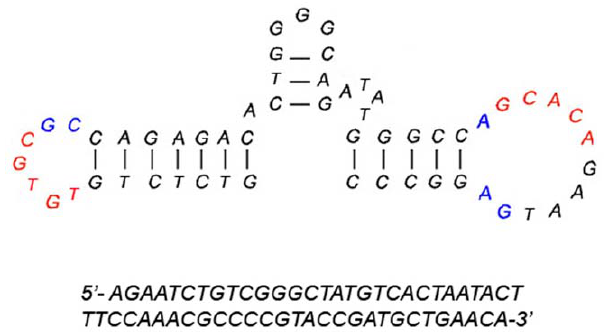
Figure 1. Aptamer sequence. Schematic of the aptamer sequence used in this experiment (top). The two complementary regions shown in red and the conserved bases shown in blue are thought to form the target binding site. Also shown is the sequence of the random oligonucleotide control (bottom).